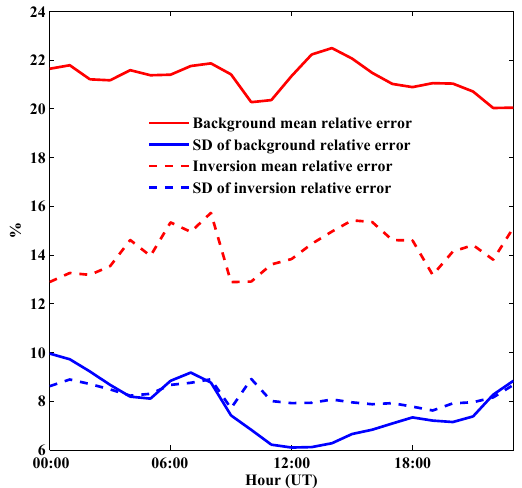
Figure 4. The average relative reconstruction error and standard de- viation using regularization method I under the background I situ- ation. The red solid line is the average relative error of the back- ground electron density. The blue solid line is the standard deviation of the background relative error. The red dashed line is the average relative error of the reconstructed electron density. The blue dashed line is the standard deviation of reconstructed relative